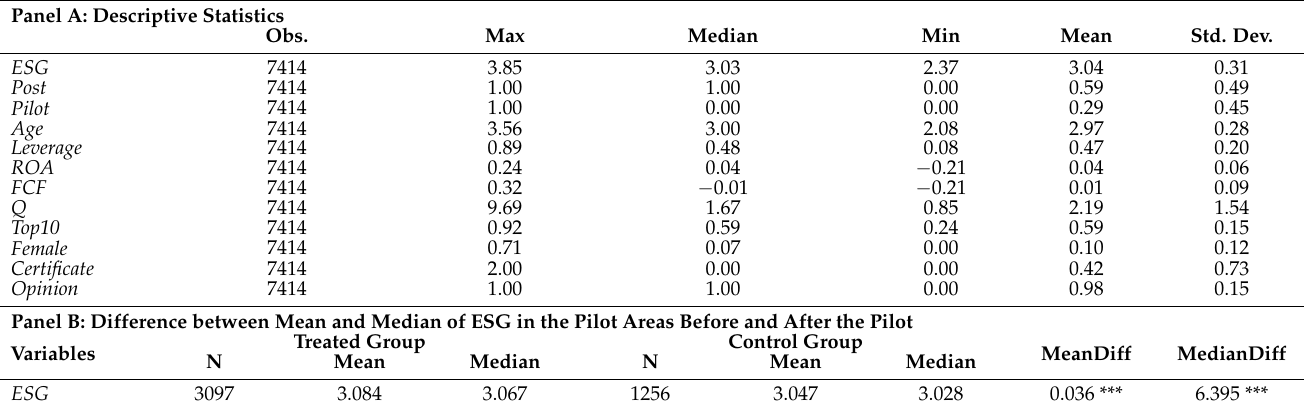
Table 1. Summary statistics.